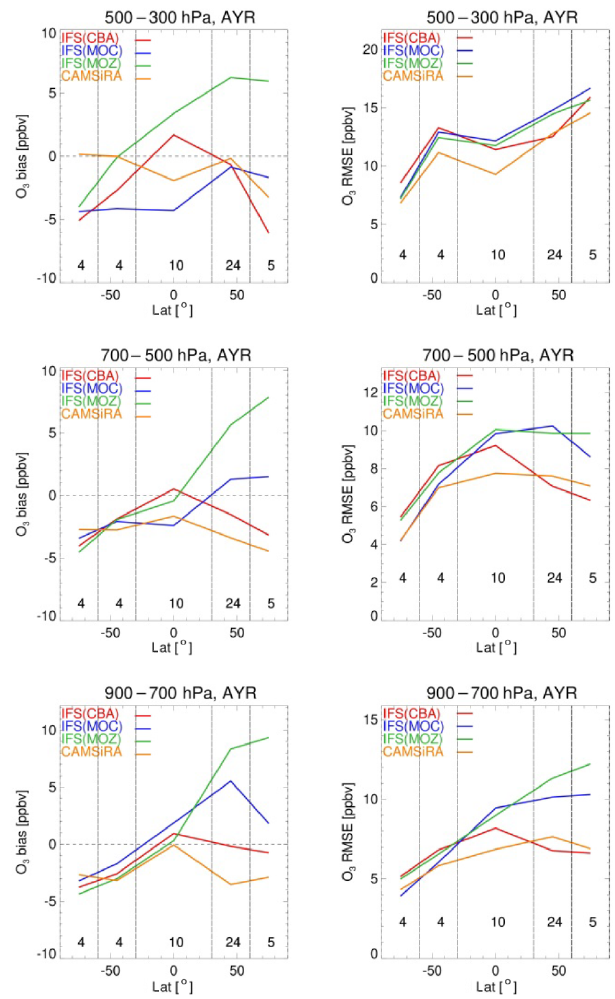
Figure 7. Mean of all model biases (a) and RMSE (b) values against ozone-sondes as a function of latitude for various pres- sure ranges (top row: 300–500; middle row: 500–700; bottom row: 700–900hPa), averaged over the full year. Same colour codes as in the previous figure. The numbers in each latitude range indicate the number of stations that contribute to these statistics. For refer- ence, the corresponding results from the CAMS interim reanalysis (CAMSiRA) are also given in